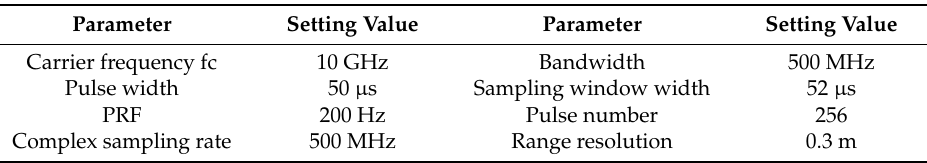
Table 1. Parameter settings of the radar